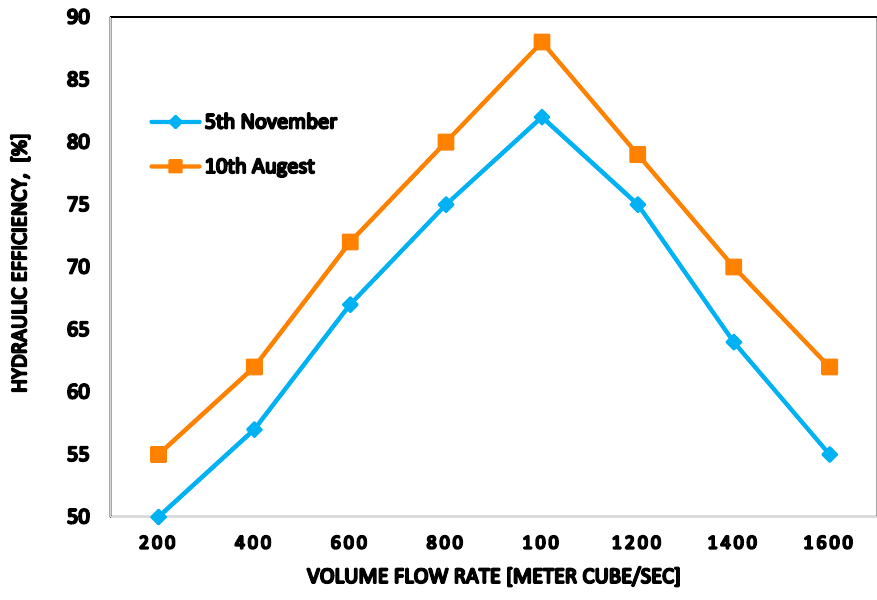
Figure 8. Turbine efficiency measurements at TDHP [17].